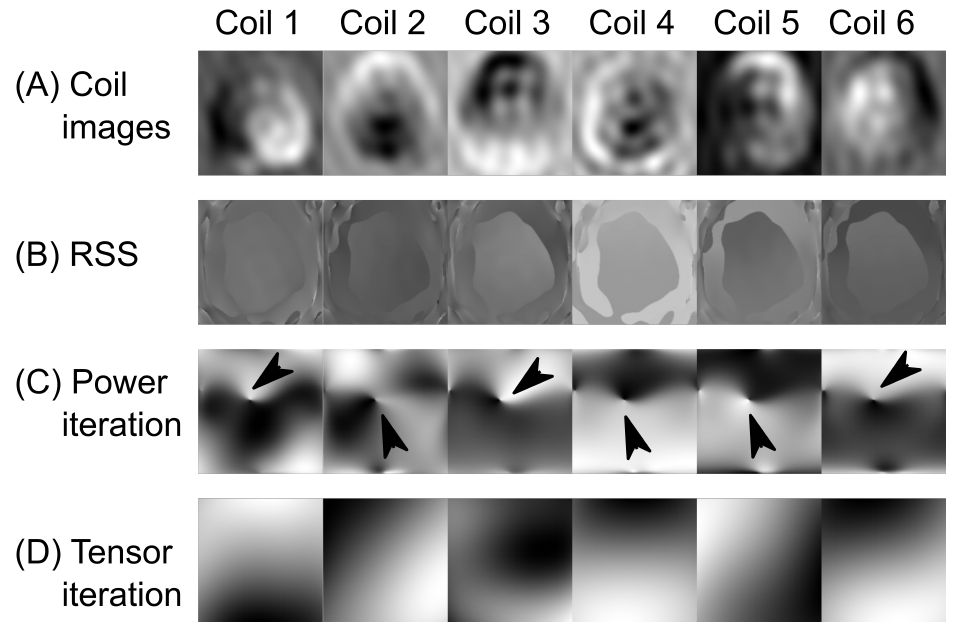
Figure 2. Comparisons between estimation methods for coil sensitivity profiles of coils 1–6. Only real-valued images are shown. ( A ) Coil images: The real part of the low-resolution coil images. ( B ) RSS (root-sum-squared): The low-resolution images divided by the RSS, but exhibiting phase wrapping. ( C ) The power iteration causes phase singularity (arrow heads) in all six channels. ( D ) Tensor iterations extracted smooth sensitivities. Although the intensity distributions between ( C ) and ( D ) looked different, both solutions were valid eigenvectors which were non-unique. However, the phase singularities in ( C ) could affect the homogeneity of complex-valued